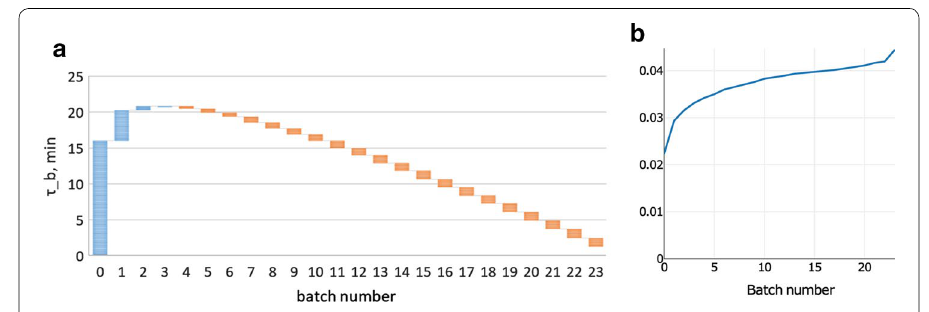
Fig. 11 Prediction time: a forecast calculation time, b earliness calculated by the Eq.